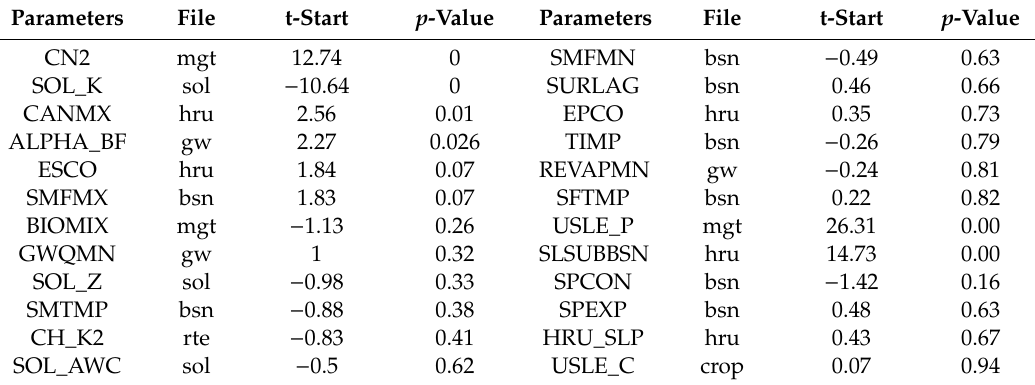
Table 2. Sensitivity analysis results of parameters in the calibrated and validated